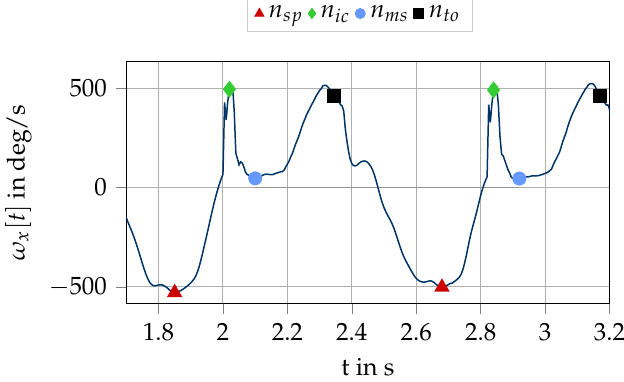
Figure 6. Visualization of the stride segmentation for the cavity sensor using the gyroscope signal in the sagittal plane ω x [ t ] . The fiducial points at swing phase n SP are local minima of the angular rate in the sagittal plane. The index n IC indicates the index of IC, which corresponds to the bias corrected local maximum after n SP . The MS event n MS is at the minimum of the gyroscopic energy. The TO event at n TO is based on the second local maxima and a bias